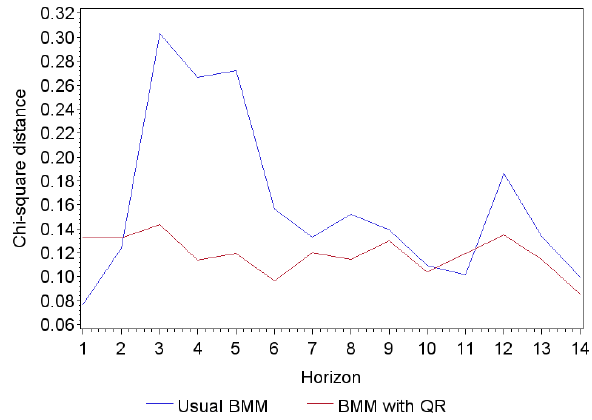
7 Fig. 5. Comparison of Probability Integral Transform deviations from theoretical distribution for horizon 3. The point labeled « 1 », with coordinates (0 . 02 , 0 . 095), shows that for raw Ensemble Prediction System (« raw EPS »), the realized temperature is lower than 2% of the simulated values on 2+9.5=11.5% (rather than 2%) of the dates. For Best Member Method, denoted by « Usual BMM » (resp. Best Member Method with error modeling using quantile regression, denoted by